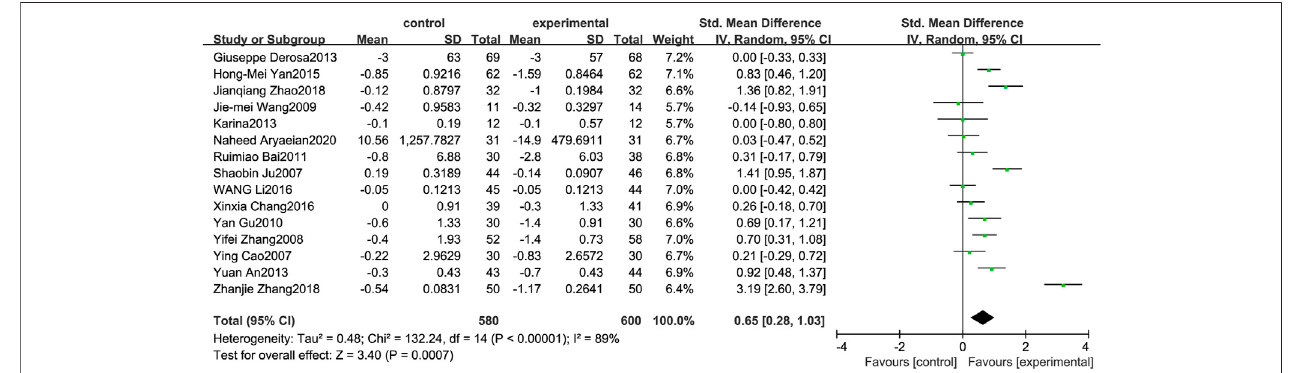
FIGURE 8 | Meta-analysis and migration analysis of the effect of berberine on fasting plasma glucose. Forest plot illustrates the differences in changes in fasting plasmaglucose in adults withmetabolic disease who did ordid notreceiveberberine in13trials( n (cid:1) 1,052). The meandifference (bluesquares), 95%CI(horizontallines through blue squares), and pooled-effect sizes (green diamonds) were presented using random-effect Hedges models.